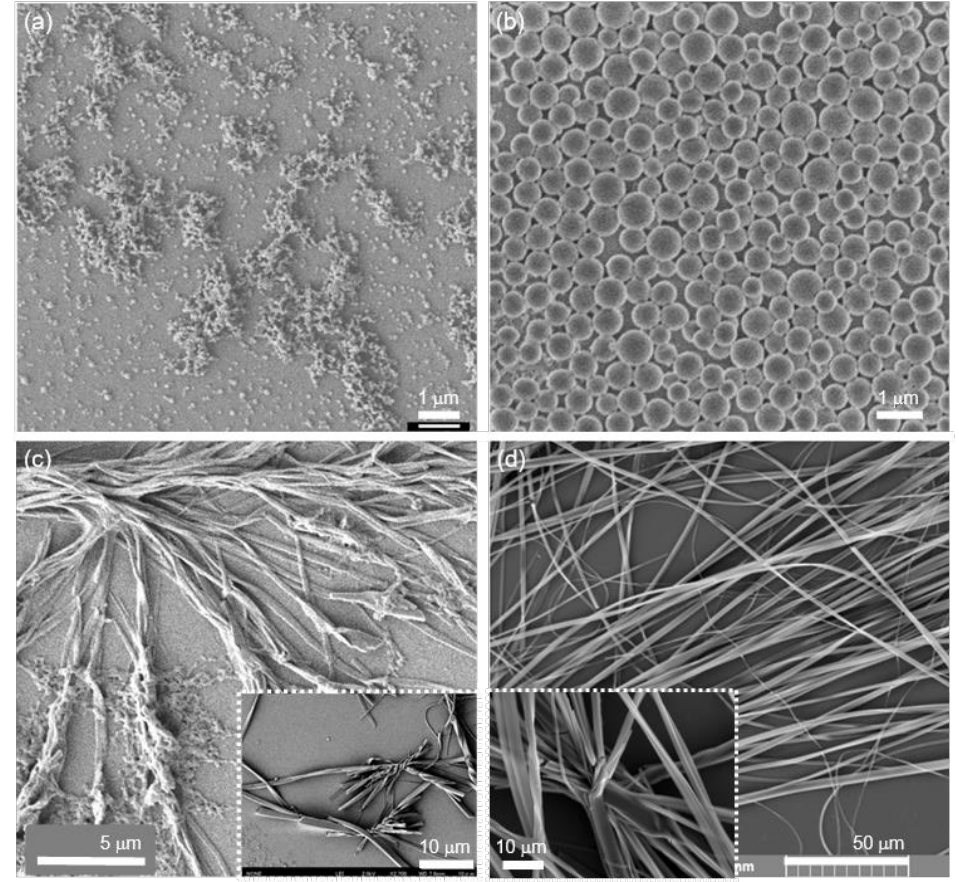
Figure 4. SEM images of self-assembled structures obtained from ( a ) DMF-H 2 O (1/3, v / v , 10 µ M), ( b ) THF-H 2 O (1/4, v / v , 20 µ M), ( c ) DMF-H 2 O (1/1, v / v , 100 µ M), and ( d ) toluene-MeOH (1/4, v / v , 100 µ M)